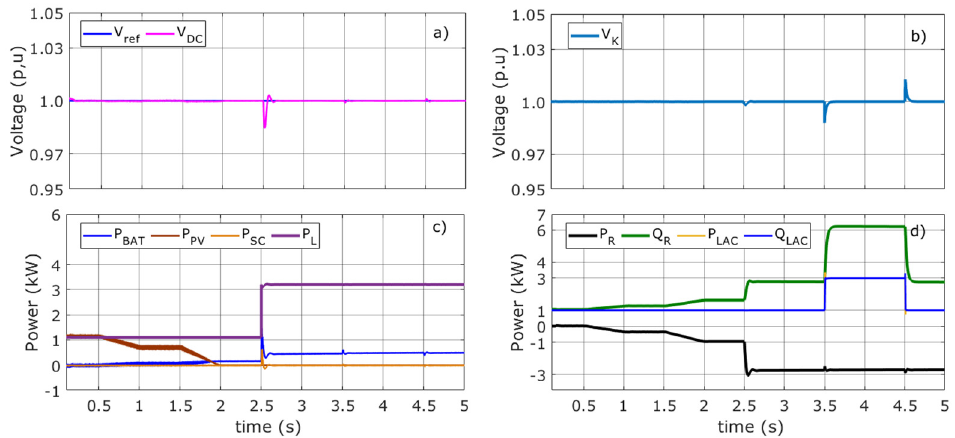
Figure 7. Voltage and power flow in Mode 2. ( a ) Reference and DC bus voltage ( b ) AC voltage ( c ) Battery, photovoltaic, SC, and load powers ( d ) Active and reactive VSC powers, active and reactive load powers.